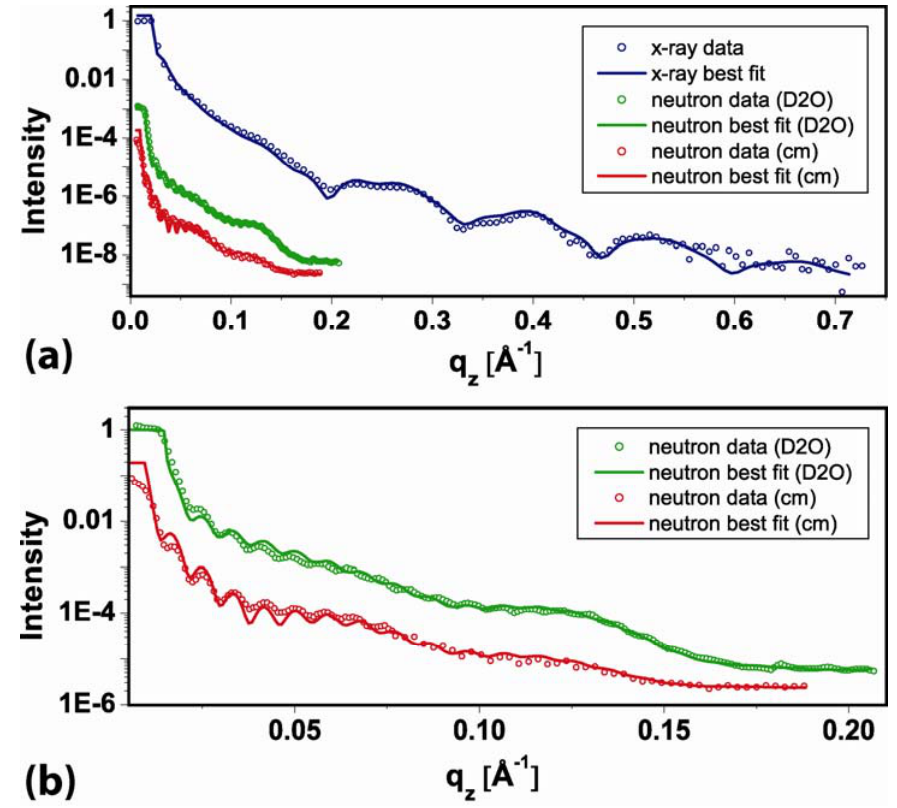
Figure 2. Reflectometry data and best fits of the SLB/streptavidin /AK-cyclo[RGD] trilayer in liquid environment (Figure 1a). ( a ) The reflected intensity is plotted against the . Intensity scale is logarithmic and normalized to a total reflection momentum transfer q z signal of 1. The reflectometry data are represented by open symbols, curves represent best fits. The neutron measurements are shown in green [ D O ] and red [ cm ], the X-ray 2 measurement is shown in blue; ( b ) Expanded view of the neutron data and best fits. Colors and symbols are as in